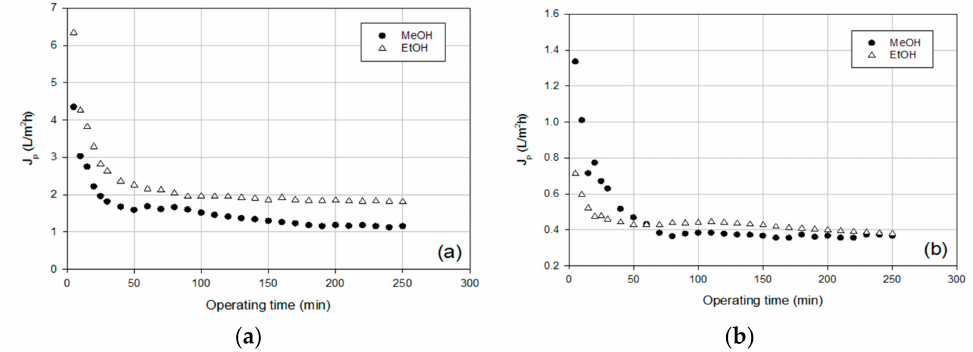
Figure 2. Permeate flux as a function of operating time in nanofiltration of methanol and ethanol extract of S. nigra ( a ) leaves and ( b )